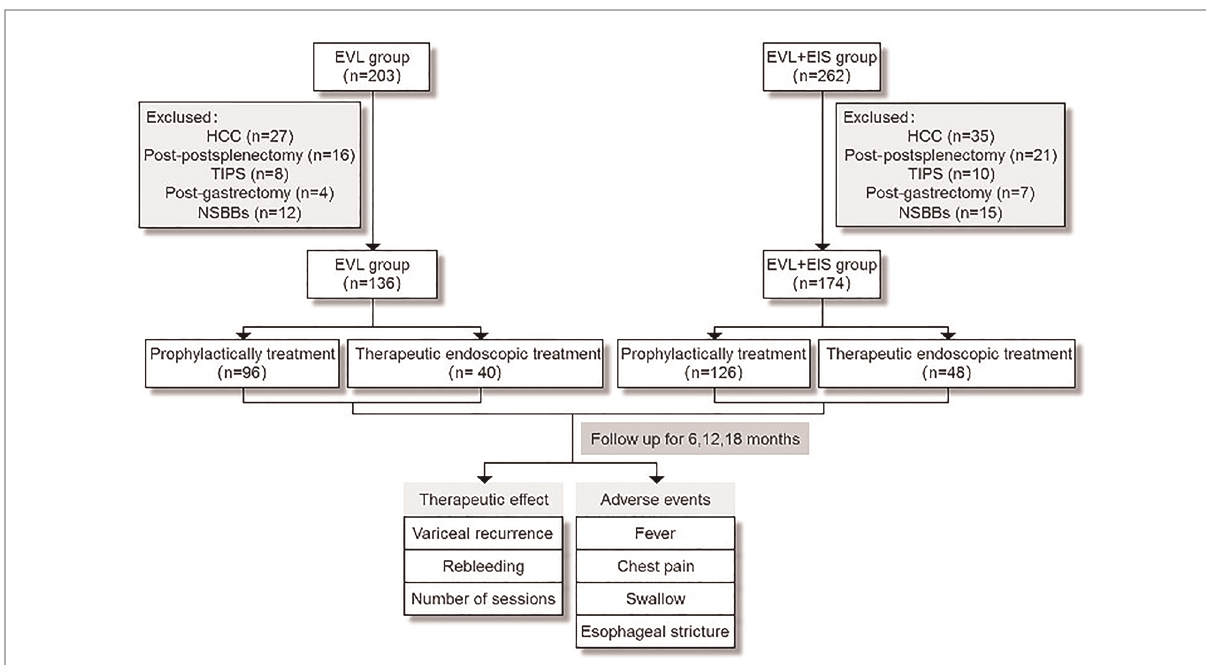
FIGURE 2 Flow diagram of this study population. EVL, esophageal variceal ligation; EIS, endoscopic injection sclerosis; HCC, hepatocellular carcinoma; TIPS, transjugular intrahepatic portosystemicstent-shunt; NSBBs, non-selective